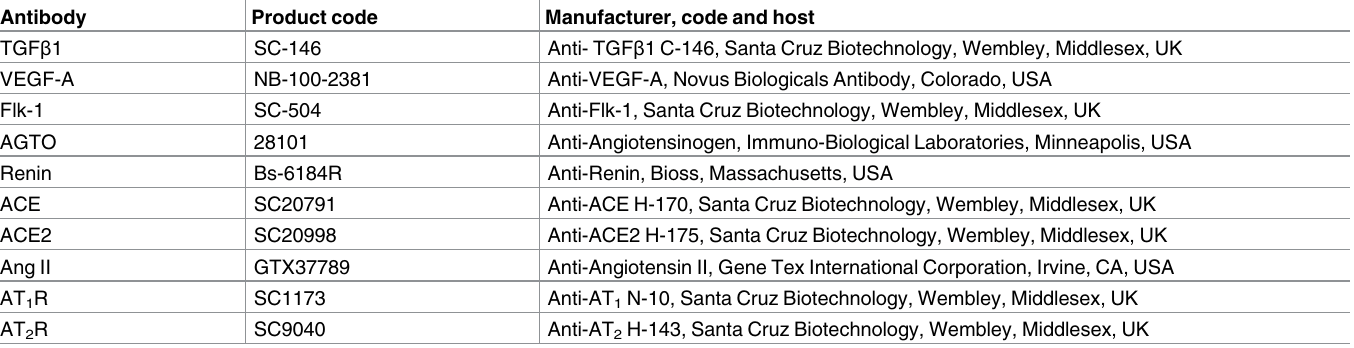
Table 1. Antibodies used for ELISA protein expression protocol. Antibody Product